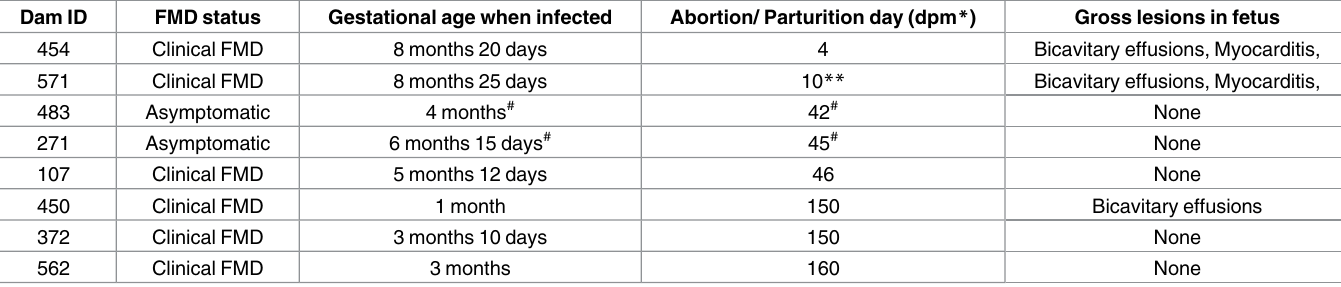
Table 1. Clinical status of FMDV infected cows and post-mortem findings in aborted fetuses and dead calves. Dam